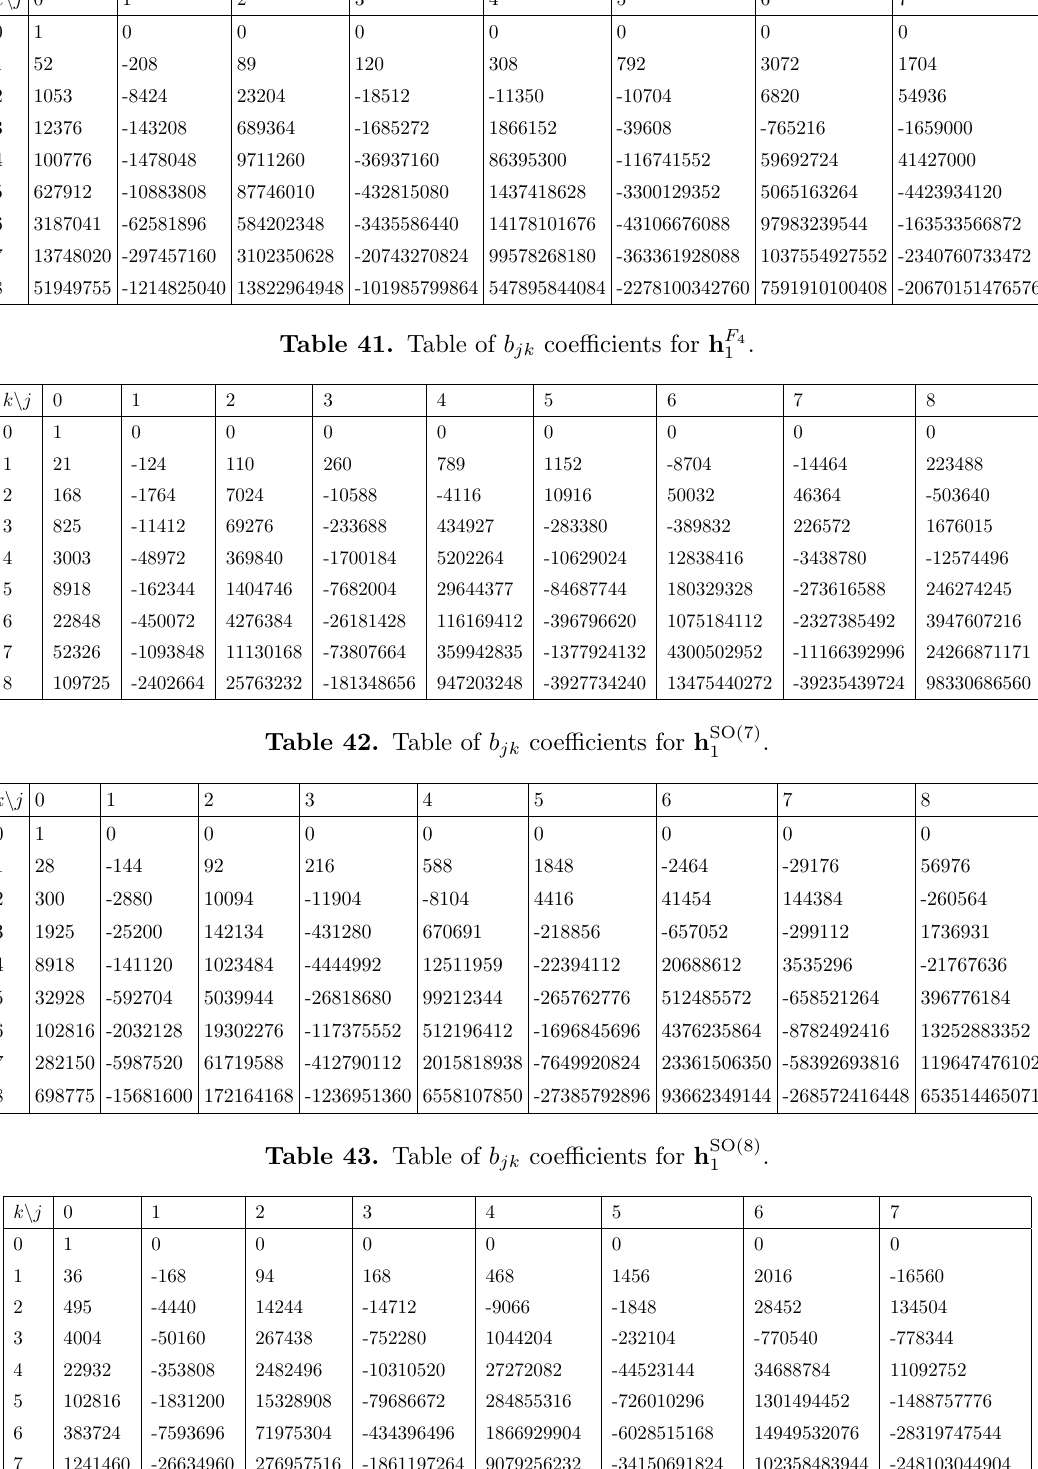
Table 44. Table of b jk coe(cid:14)cients for h SO(9)